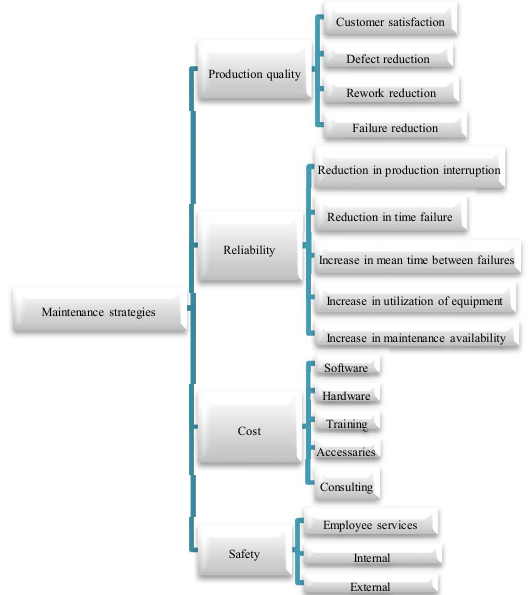
Fig. 1. The structure of the proposed study